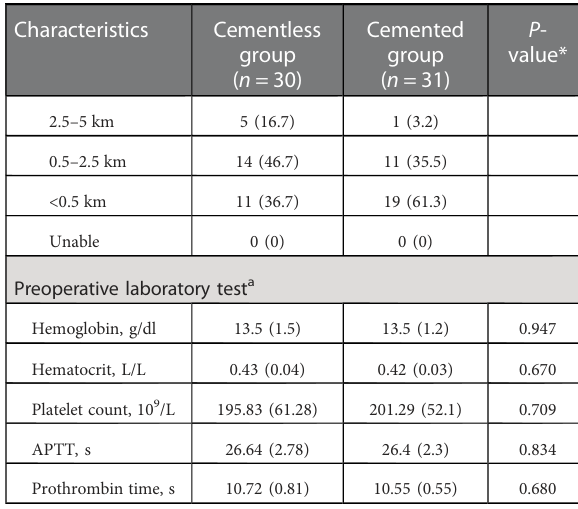
TABLE 1 Baseline